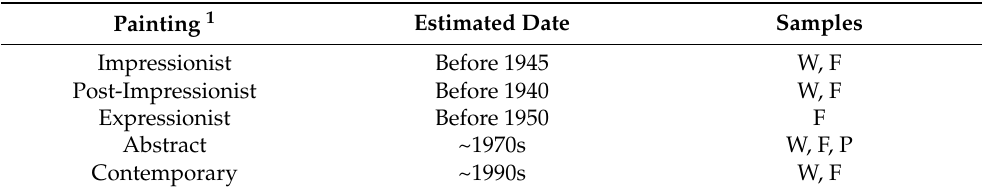
Table 2. Paintings and materials selected for 14 C dating: wood from stretcher (W), fiber from canvas (F), paint (P). (F), paint (P).